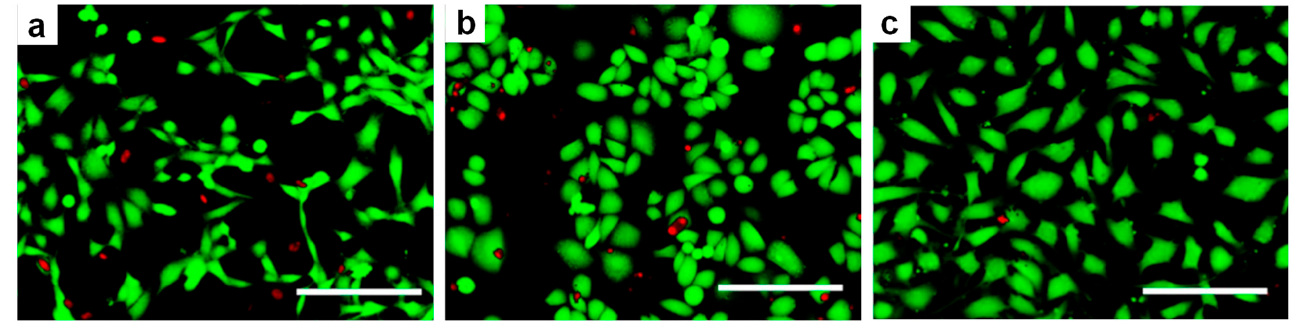
Figure 4. ( a – c ) Fluorescent micrographs of 3T3 fibroblasts ( a ), HaCat keratinocytes ( b ) and EA.hy926 endothelial ( c ) cells cultured on PHBV-GelMA patches. Scale bars: 200 µ m. Adapted with permission from ref. [113].